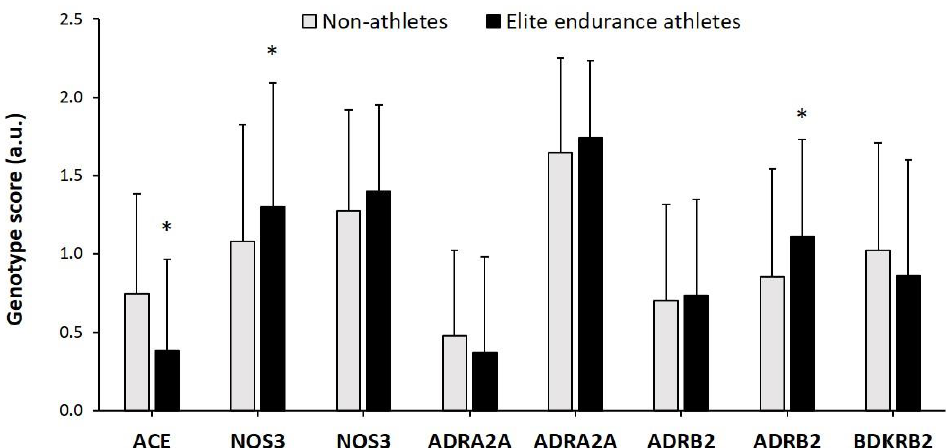
Figure 1. Individual genotype scores in elite endurance athletes and controls. Table 1. Studied polymorphisms in elite endurance athletes and